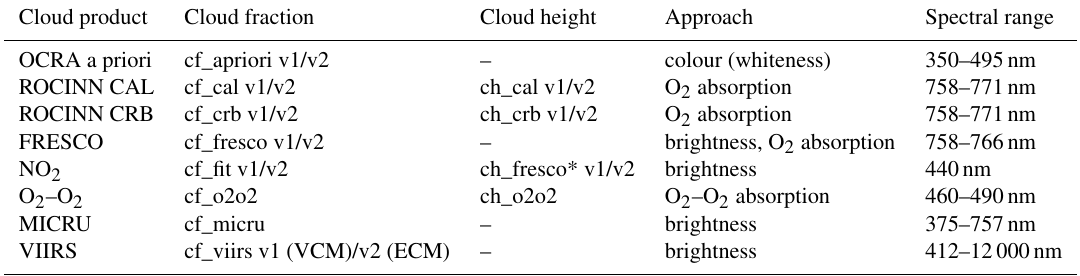
Table 1. Overview of the cloud products with abbreviations for the version 1 (v1) and version 2 (v2) cloud fraction and cloud height parameters included in this study, their approaches, and the spectral ranges. MICRU and O 2 –O 2 have only one version. Cloud product Cloud fraction Cloud height OCRA a